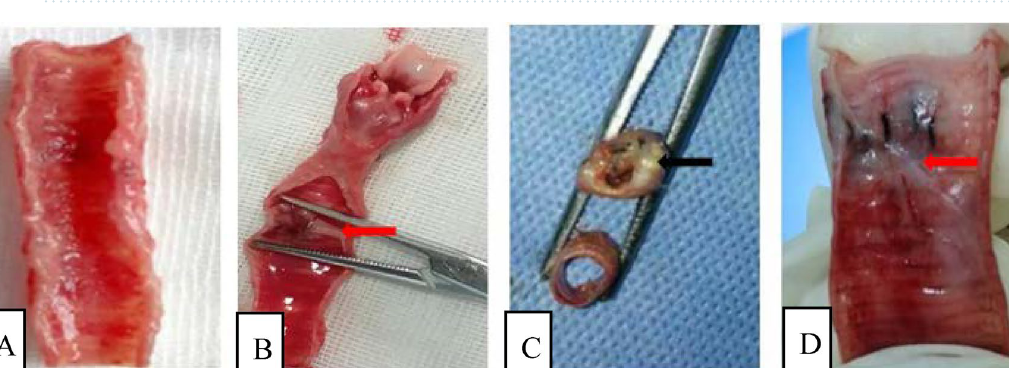
Figure 2. Follow-up pictures of experimental rabbits under bronchoscopy. ( A–D ) The follow-up pictures of experimental rabbits in group A, B, C and D, respectively.